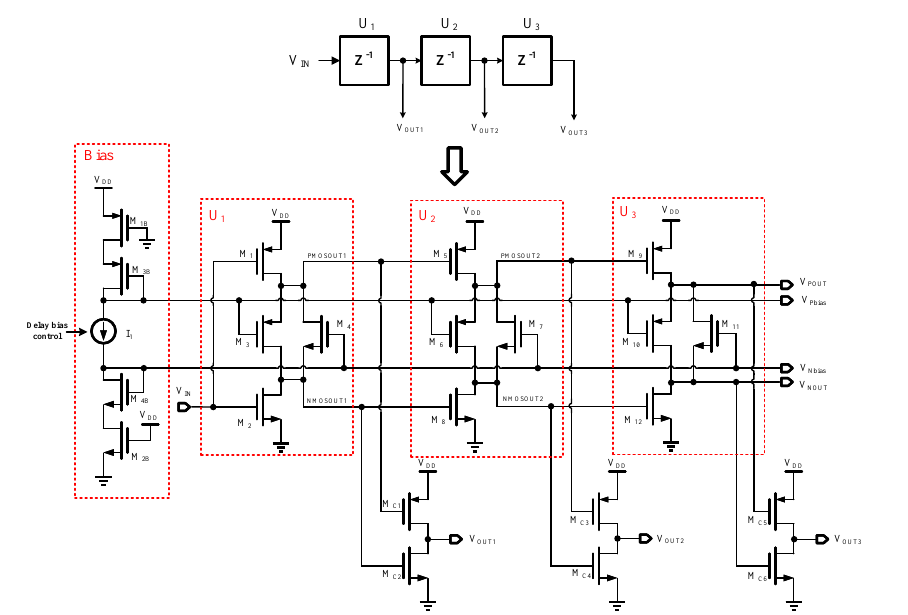
Figure 5. Delay-line circuit independent of supply voltage. To see how the bias transistors control the delay of the delay line, we assume a high input signal at the input node V IN . When the input V IN is high, transistor M 2 will turn on, and the value of NMOSOUT1 from transistor M 2 will be pulled to ground with no delay. This will, in turn, cause the next NMOS transistor M 8 to immediately turn off, as there is no propagation delay from the now-low output of transistor M 2 to the gate of transistor M 8 . Since transistor M 8 is now off, no signal can propagate from M 2 to M 12 . On the other hand, the only way for NMOS transistor M 12 to turn on is to receive the high voltage V DD through transistors M 6 and M 7 , which in turn only receive that voltage when PMOS transistor M 5 is on. Further, PMOS transistor M 5 only receives a low input signal from transistor M 2 through transistors M 3 and M 4 . Thus, any signal reaching transistor M 12 must pass through transistors M 3 and M 4 first, and then through M 6 and M 7 . When the signal at input node V IN changes, the new signal will be propagated down the delay line at a speed dictated by the delay of each unit delay element as limited by the bias transistors rather than by the speed of the transistors that accept the input signal and provide delayed output signals. If the bias lines V Nbias and V Pbias are provided with voltages derived from a constant current, the delay will be constant and independent of the power supply voltage V DD . Current Source I 1 provides a tunable constant current independent of the power supply voltage, and transistors M 3 B and M 4 B define the PMOS bias voltages. By tuning the current source I 1 , the unit delay time can be adjusted to keep track of different input frequencies. A digital-controlled multi-bit current tuning mechanism can also be applied in this scenario to achieve fine-tuning of the bias current of the delay line. PMOS transistor M 3 B is selected to have the same transconductance as bias transistors M 3 , M 6 , and M 10 . While NMOS transistor M 4 B is similarly selected to have the same transconductance as NMOS bias transistors M 4 , M 7 , and M 11 . M 3 B , and M 4 B will define the Voltages on the bias lines as constant to first order and cause the delay line to have a nearly constant delay. Since M 1 B is selected to have the same